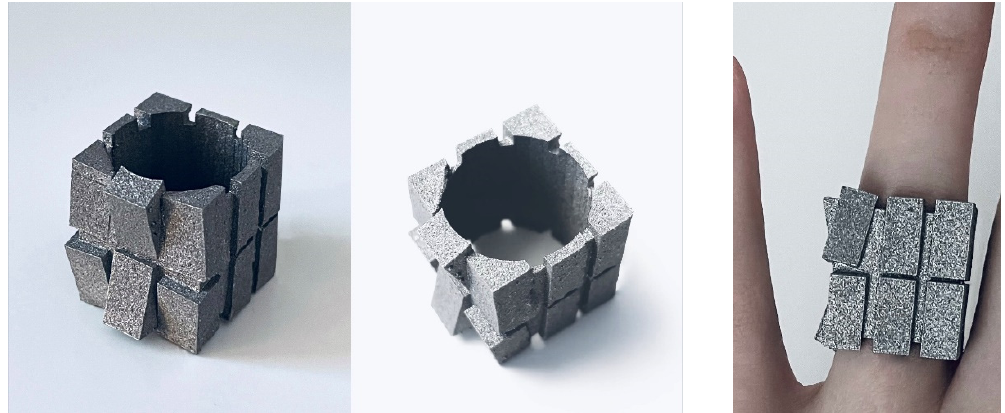
Figure 14. A ring printed with metal powder (author: Kaja Bakan).